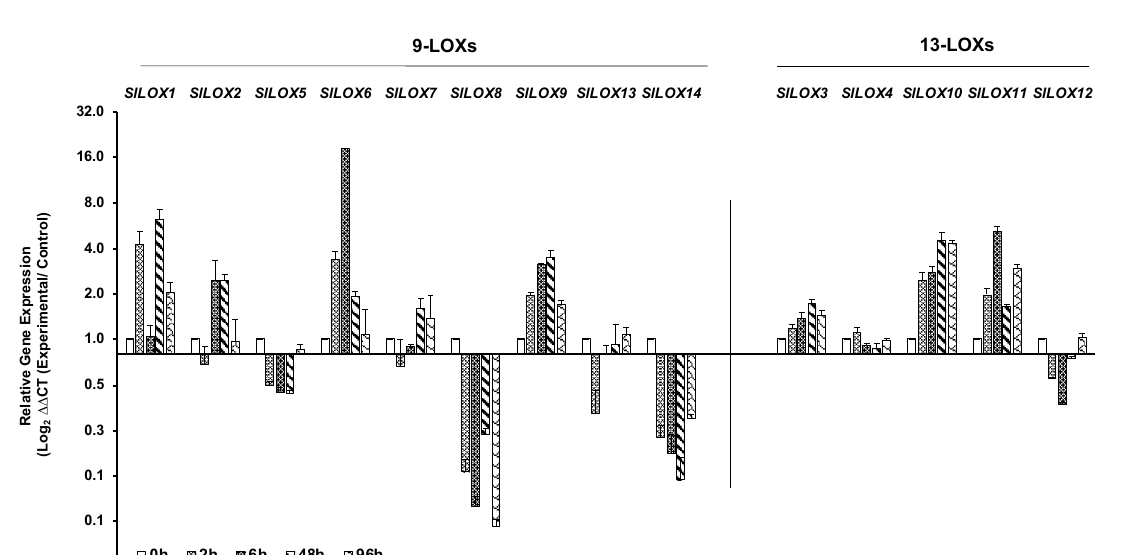
Figure 6. qRT-PCR analysis of tomato ( S. lycopersicum cv. Ailsa Craig) LOX gene family members in response to salt stress. Graphical representation of qRT-PCR data of tomato 9- LOX genes and 13-LOX genes in response to salt stress: 200 mL of 200 mM salt solution was applied daily to plants for 96 h. Non-treated control (0 h) was used as calibrator in qRT-PCR data calculation and for defining